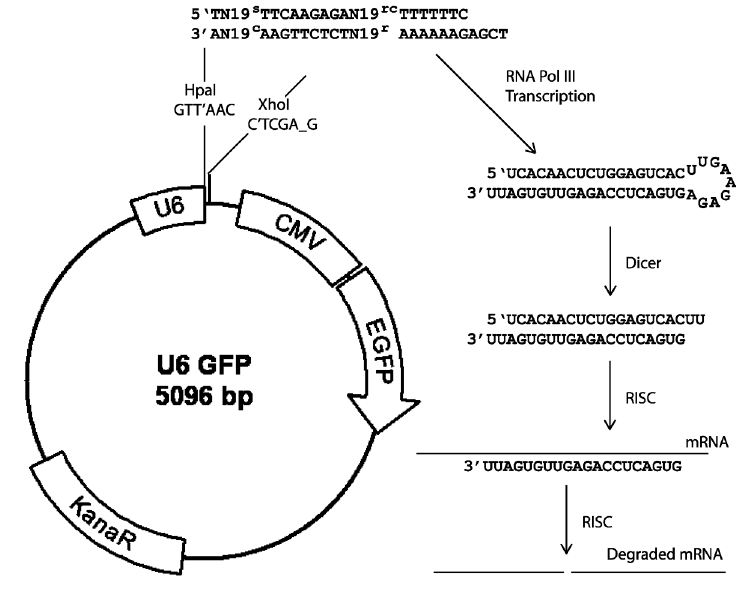
Figure 1. Plasmid-mediated RNA interference. Basic components of the small-interfering RNA-producing plasmid include an RNA polymerase III (RNA Pol III) promoter (U6 or H1) upstream of the insert site of the dsDNA, an indication (GFP, green fluorescent protein) and a selection marker (KanaR/ NeoR). CMV - cytomegalovirus; EGFP = enhanced green fluorescent protein; RISC = RNA-induced silicencing complex; s = sense; r = reverse; c = complement; rc = reverse complement . Map generated in pDraw32 (www.acaclone.com).